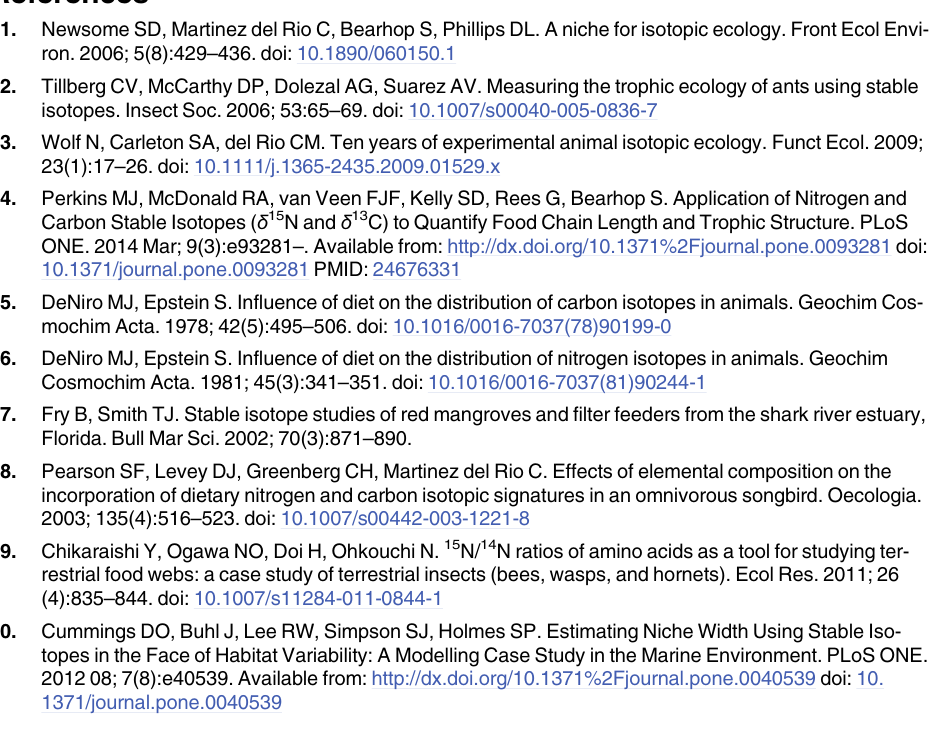
S2 Table. Models and contrasts used to inspect the effects of preservation methods on the δ 15 N, δ 13 C isotopic values, %N, %C total content and C/N atomic values of Mellopsis dou- casae sp. samples. Model simplification was performed by backward term extraction, remov- ing one term at a time, performing consecutive one degree of freedom contrast analyses. Minimum Adequate Model ’ s significance was evaluated contrasting it with the null